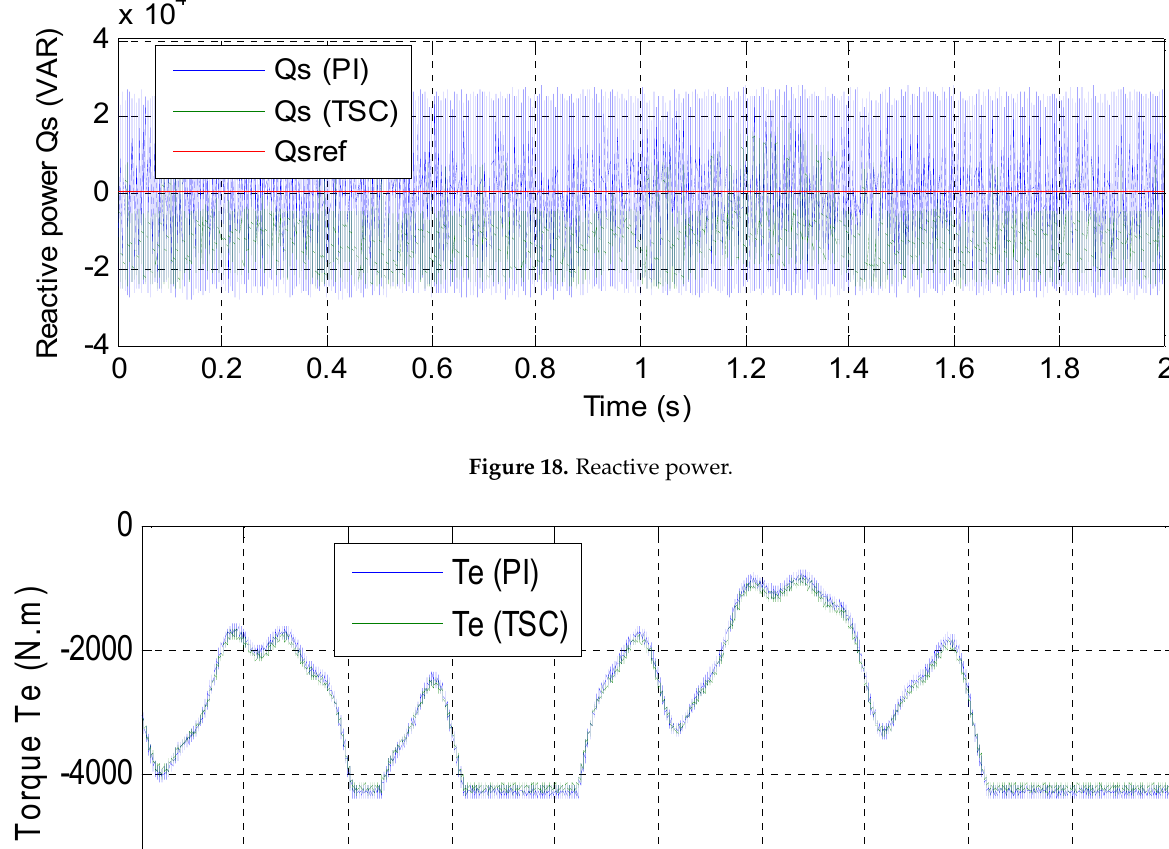
Figure 17. Active power.